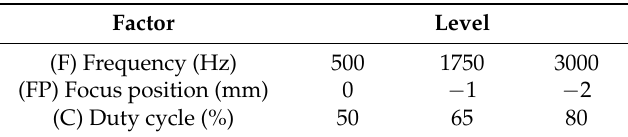
Table 4. Factors and levels used in the interdependence study (a focus position of 0 mm corresponds with the focal spot on the surface of the slate tile; negative values refer to positions underneath the